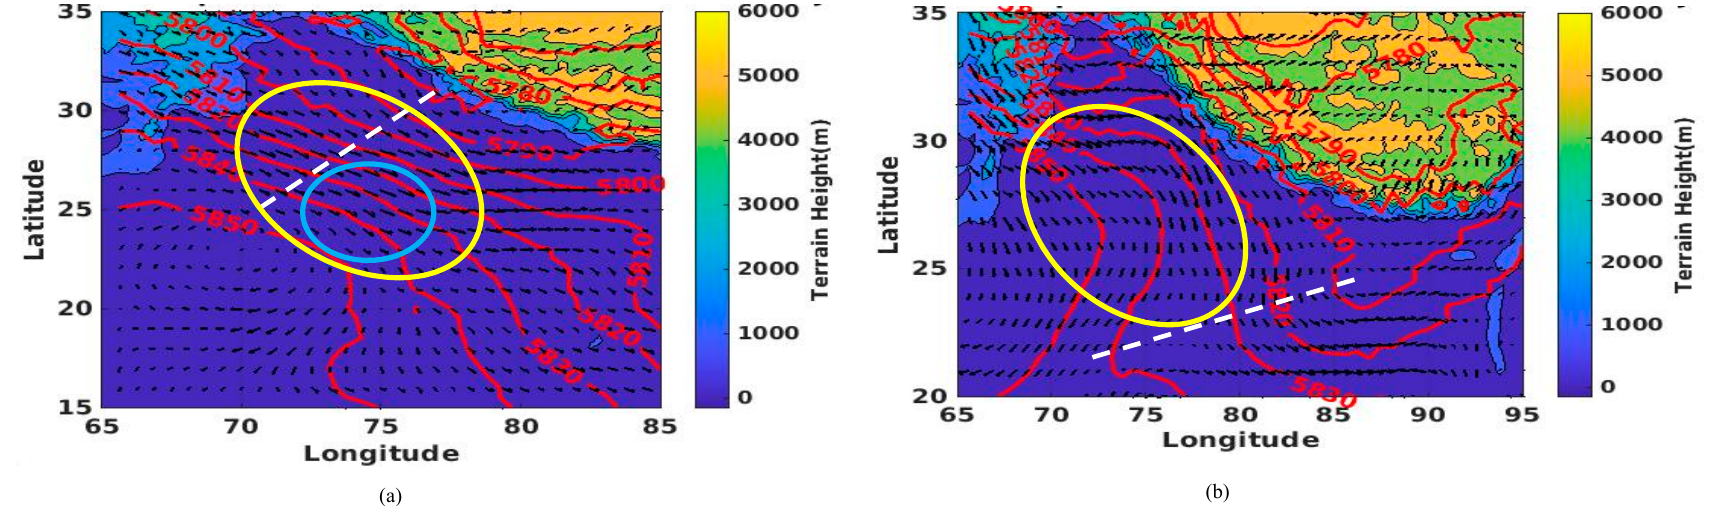
Figure 4. ( a ) Geopotential height and wind speed/direction at 500 hPa at 0630 UTC on 12 June 2018. The yellow colored circle shows the flow of jet and the white dotted line indicates a trough axis from the Modern-Era Retrospective analysis for Research and Applications MERRA reanalysis with horizontal resolution of 0.5 × 0.67° [27]. The light blue colored circle shows the area of dust storm and the thunderstorm outbreak; ( b ) Geopotential height and wind speed/direction at 500 hPa on 0930 UTC on 15 June 2018. The yellow colored circle shows the flow of jet and the white dotted line indicates a trough axis from the Modern-Era Retrospective analysis for Research and Applications (MERRA) reanalysis with horizontal resolution of 0.5 × 0.67°[27].